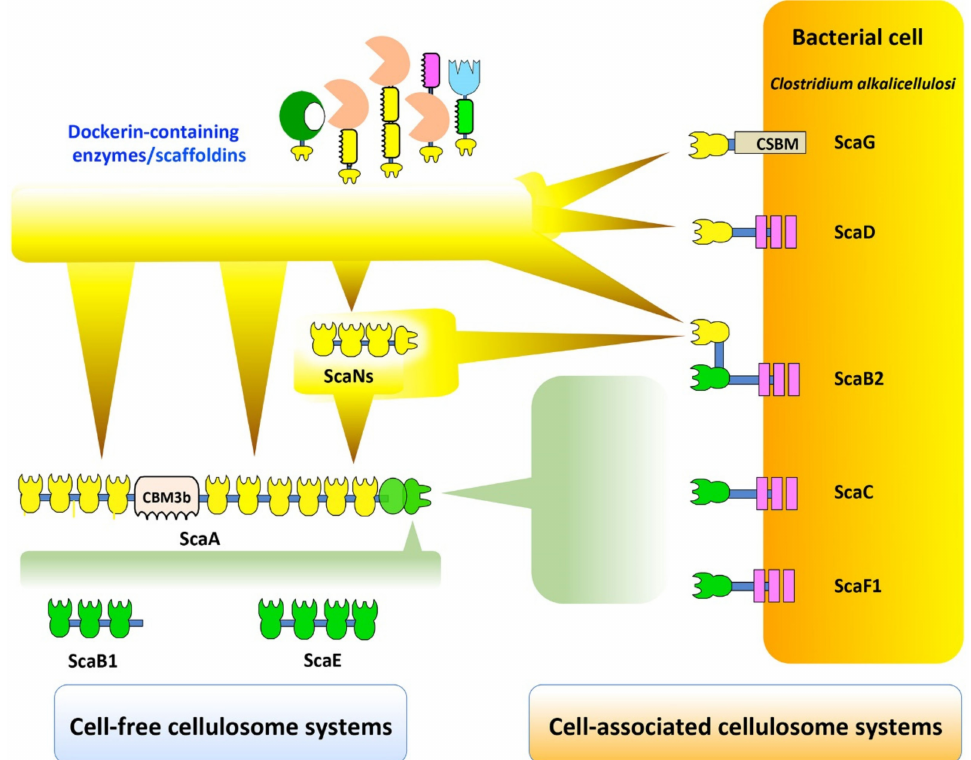
Figure 5. Exploratory view of cell-free and cell-associated cellulosomal systems in C. alkalicellulosi . The scheme represents the putative interactions among sca ff oldins, cohesins, and dockerins, according to the specific binding study by a ffi nity-based ELISA (Figure 4 and Figure S1). At least six types of complex formation occur. Type I dockerin-containing enzymes are able to bind type I cohesins of: The primary sca ff old ScaA, ScaN, and cell-associated sca ff oldins, namely, ScaG, ScaD, and ScaB2. Additionally, type I dockerin-borne ScaN is also able to bind type I cohesins of the primary ScaA, thus increasing number of enzymes on ScaA. ScaA binds cell-associated ScaB2, ScaC, and ScaF1, as well as cell-free ScaB1 and ScaE, through type II cohesin–dockerin interaction, resulting in cell-associated and cell-free cellulosome systems,